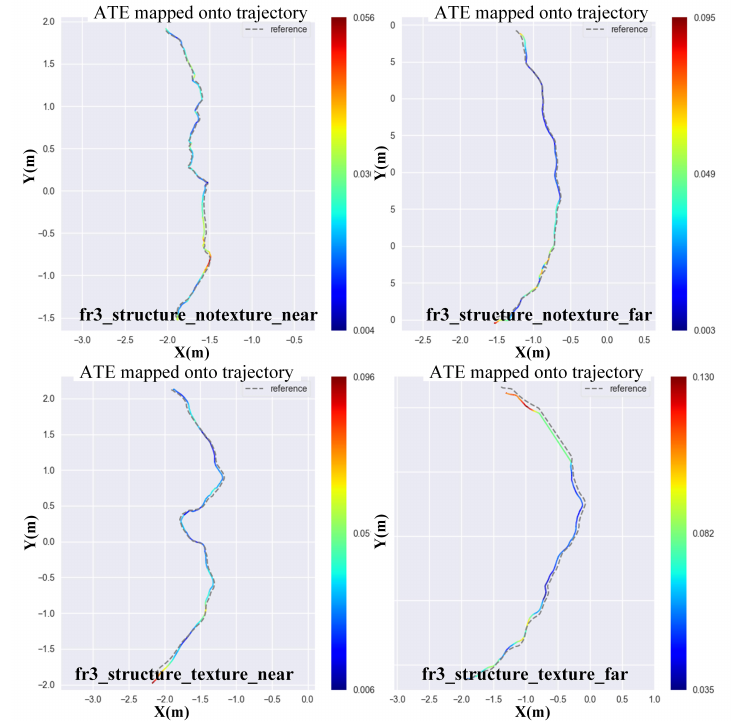
Figure 7. Ground truth vs. our trajectory for all kinds of datasets. The darkness of color reflects the value of ATE (Absolute Trajectory Error). The darker the color is, the smaller the value of ATE.